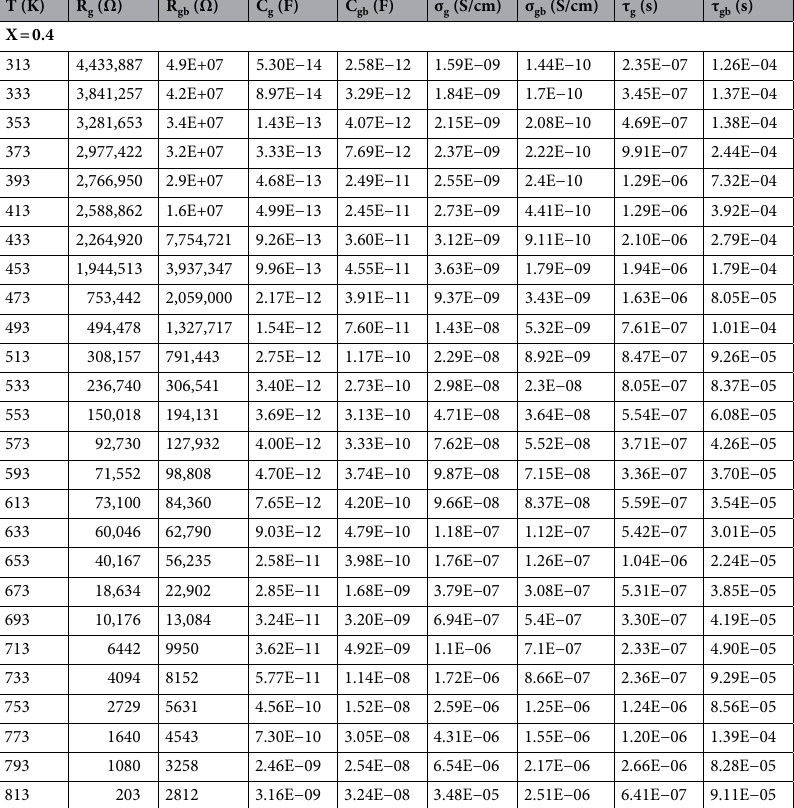
Table 5. Impedance spectroscopy parameters of X = 0.4